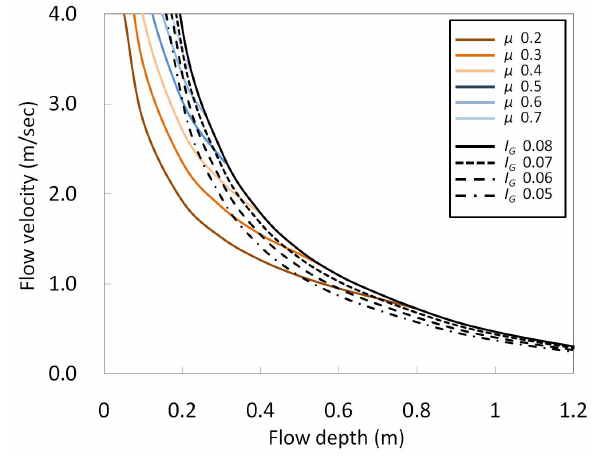
Fig. 11. Influence of the friction coefficient on the human feet soles ( µ ) and of the distance of the projection of the center of mass to the bottom back of heel ( I G ) to determine the critical condition of human